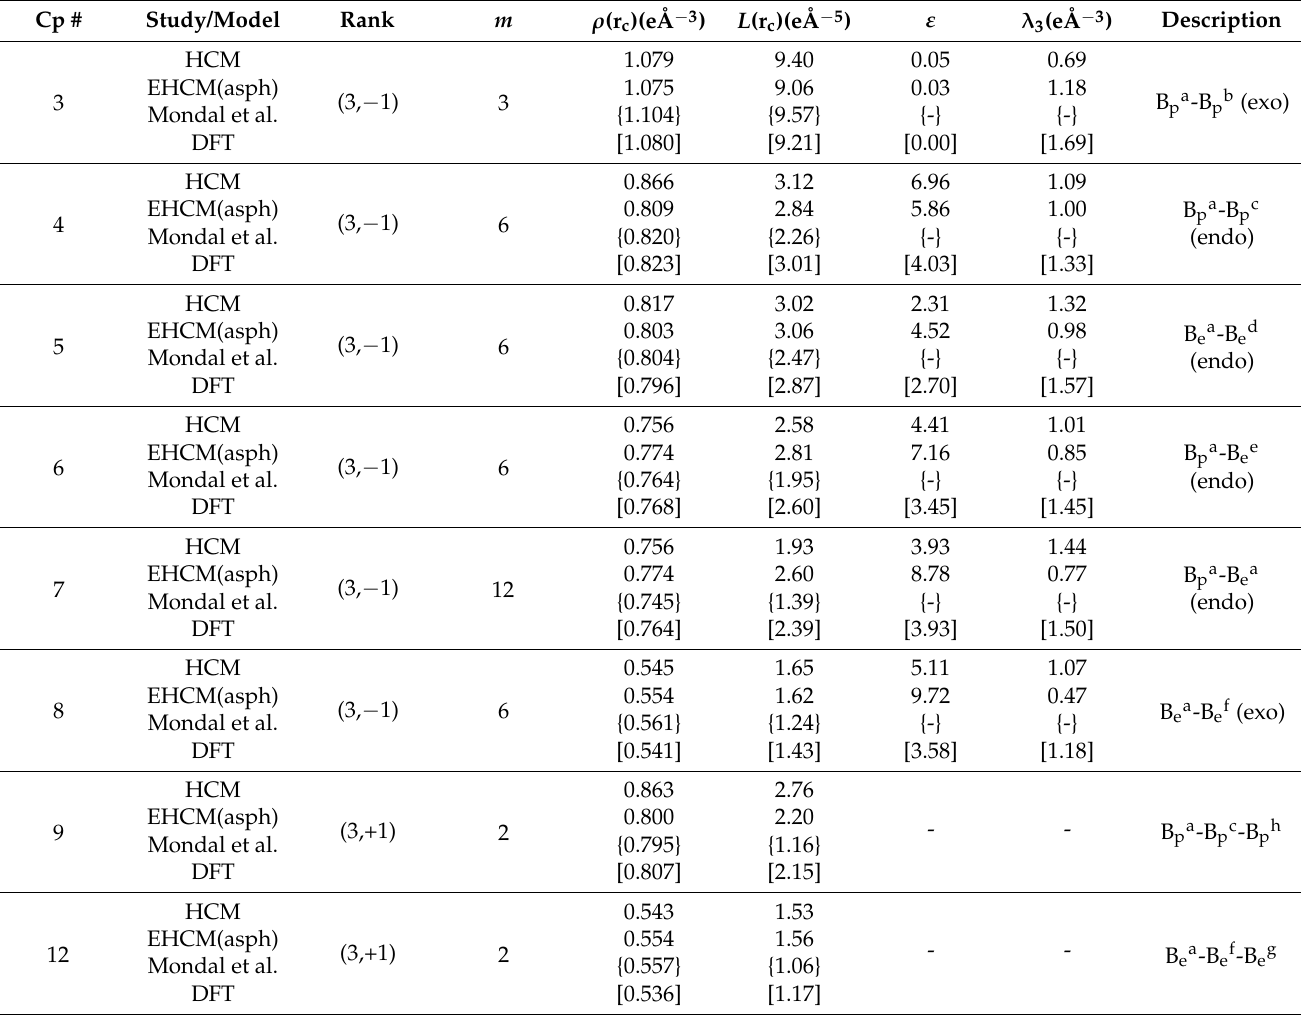
Table 1. List of selected critical points of the topology of the electron density of α -boron from refinements of experimental data of this study, the results from Mondal et al. [45] as well as the periodic DFT calculation. a x , y , z ; b − x + 2 / 3 , − x + y + 1 / 3